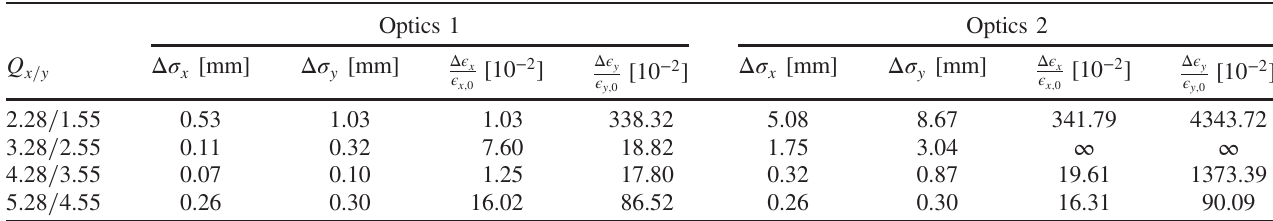
TABLE X. Deviation of the beam size Δ σ z as defined in Eq. (9) and relative emittance growth for different matches (Optics 1, Optics 2) of the regular 16-cell FODO lattice with shortened bends in one lattice cell. If the emittance growth is marked with ∞ , all particles were lost before reaching 10 000 turns.